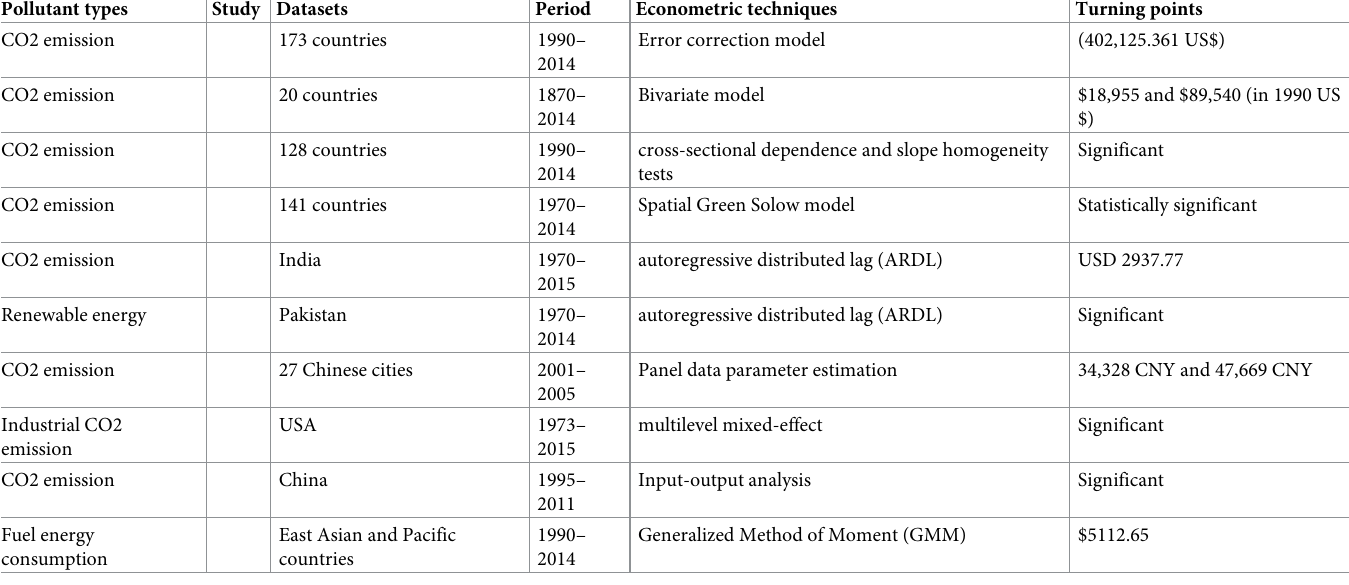
Table 3. Turning points reached earlier studies by pollutant type.